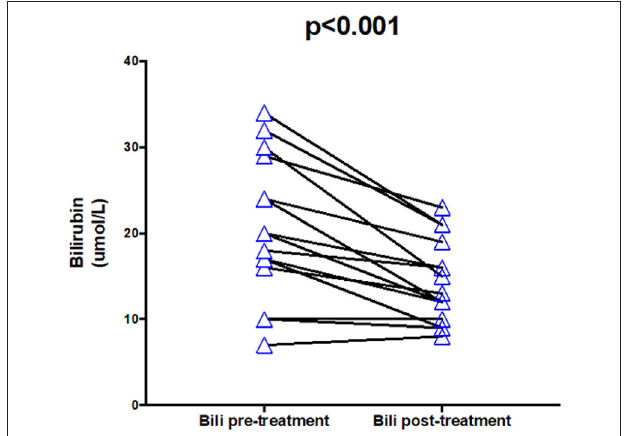
FIGURE 6 | Bilirubin pre- and post-treatment.